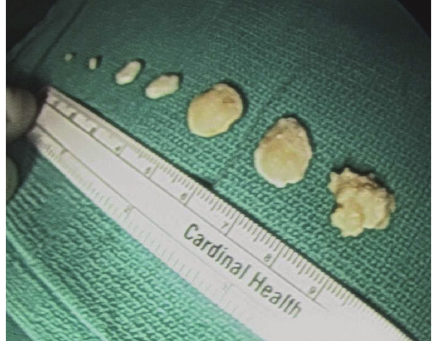
Figure 4: Multiple cartilaginous bodies of various sizes after arthro- scopic